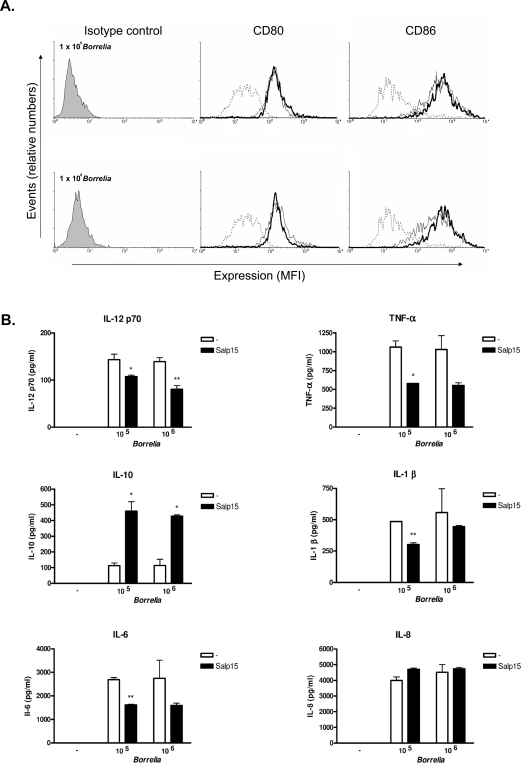
Salp15 Does Not Affect DC Maturation, but Dose-Dependently Inhibits IL-12p70, IL-6, and TNF-α Production by DCs Stimulated with Viable Borrelia burgdorferi
(A) Salp15 does not interfere with viable B. burgdorferi-induced maturation of DCs. Immature DCs were either not stimulated (dotted line), or stimulated with 1 × 10 5 or 1 ×10 6 of viable B. burgdorferi in the absence (solid line) or presence (bold line) of Salp15. The grey-filled graphs represent isotype controls. B. burgdorferi was preincubated with Salp15 for 30 min before addition of DCs. 18 h post-stimulation DCs were analysed by FACS for surface expression of CD80 and CD86.(B) Salp15 inhibits viable B. burgdorferi-induced pro-inflammatory cytokine production by DCs. The experiment was performed as in (A). However, for this assay supernatant was analyzed for cytokine production by CBA.The experiments were performed with DCs from four independent donors. Bars represent the mean of triplicates within one experiment ± SE. Differences in cytokine production between DCs stimulated with B. burgdorferi and DCs stimulated with B. burgdorferi and Salp15 were analyzed by a two-sided one way ANOVA, implementing a one way analysis of variance with Dunnett multiple comparison test. A p-value < 0.05 was considered statistically significant, indicated as one asterisk (*) 0.01 < p < 0.05 or two asterisks (**) 0.001 < p < 0.01.